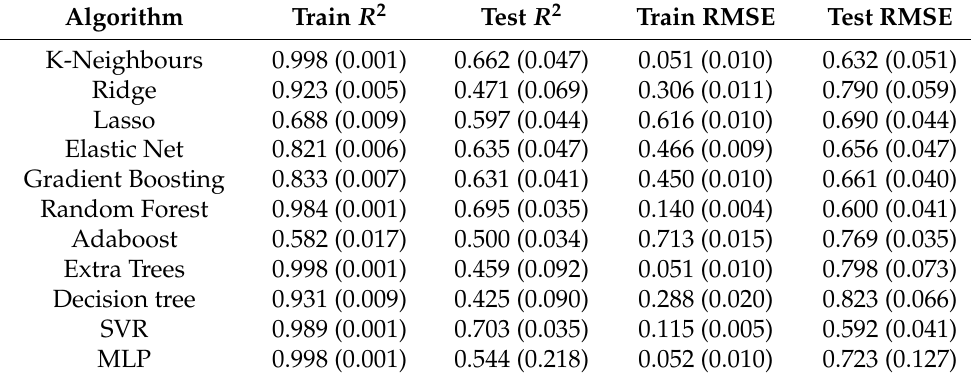
Table 1. Mean performance of each algorithm on predicting the pChEMBL value evaluated by the coefficient of determination ( R 2 ) and the root mean square error (RMSE). Standard deviations are enclosed in